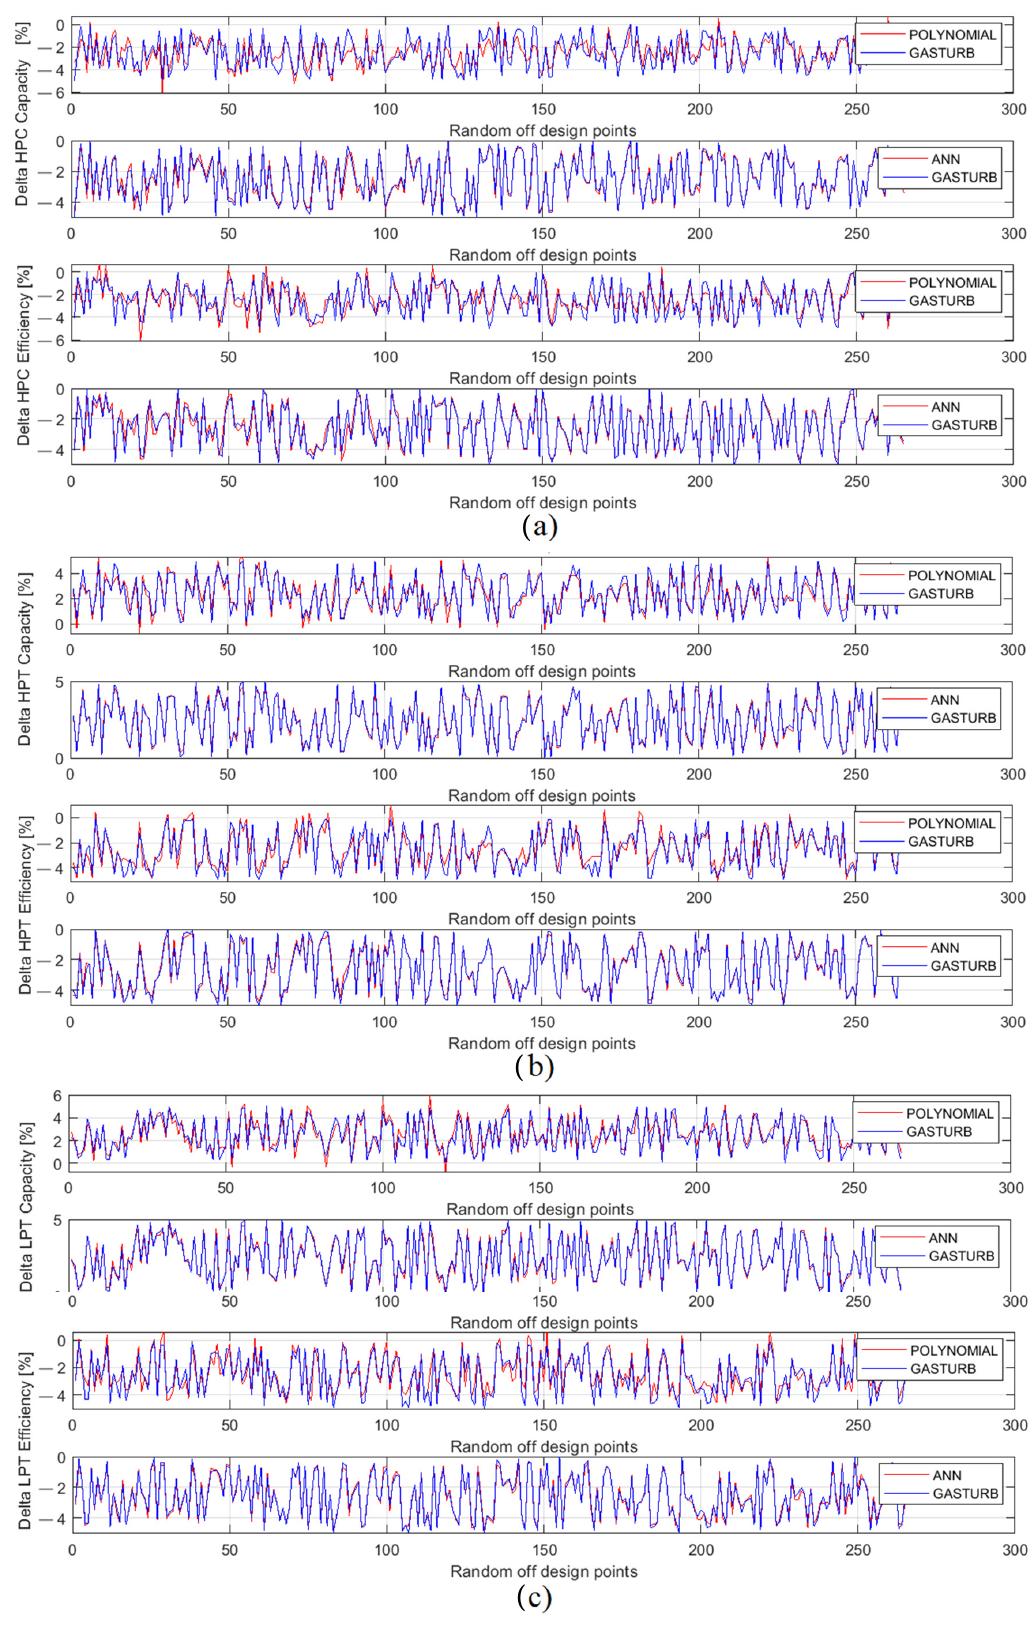
Figure 8. HPC, HPT, and LPT fault parameters generated by GasTurb and approximated by polynomials and MLP: ( a ) high pressure compressor parameters, ( b ) high pressure turbine parameters, ( c ) power turbine